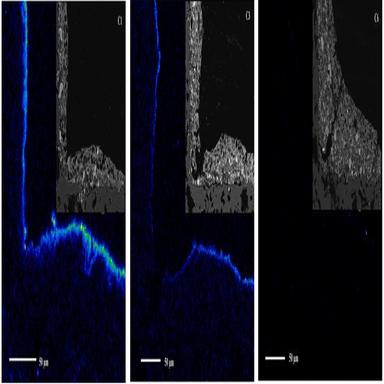
EPMA–WDS map of P from the inlet (C1), middle (C3) and outlet (C6) regions of the aged catalyst. (Inset) Corresponding BSE image.